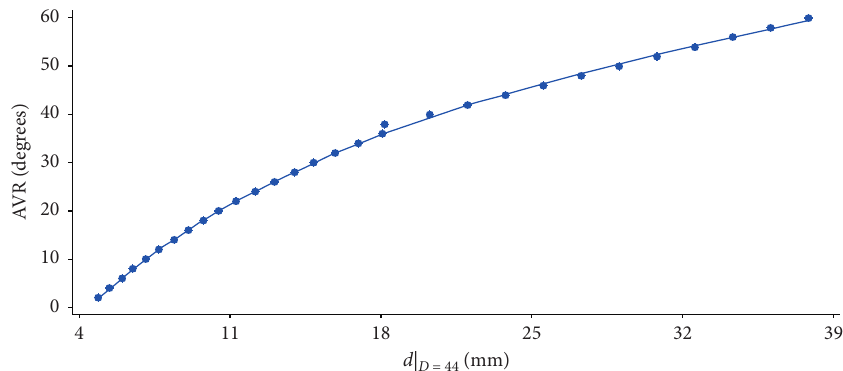
Figure 3: Adjustment of the data in column D � 44 of Raimondi’s tables to the